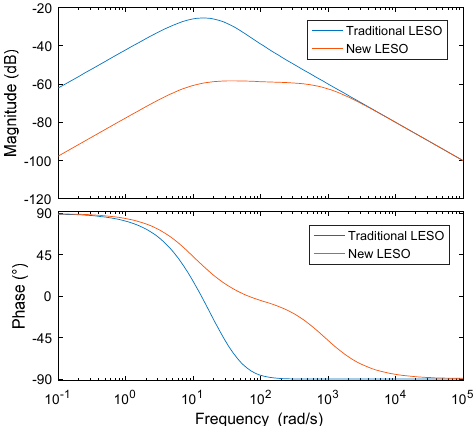
Figure 11. Logarithmic phase–frequency characteristic curves of the disturbance term.